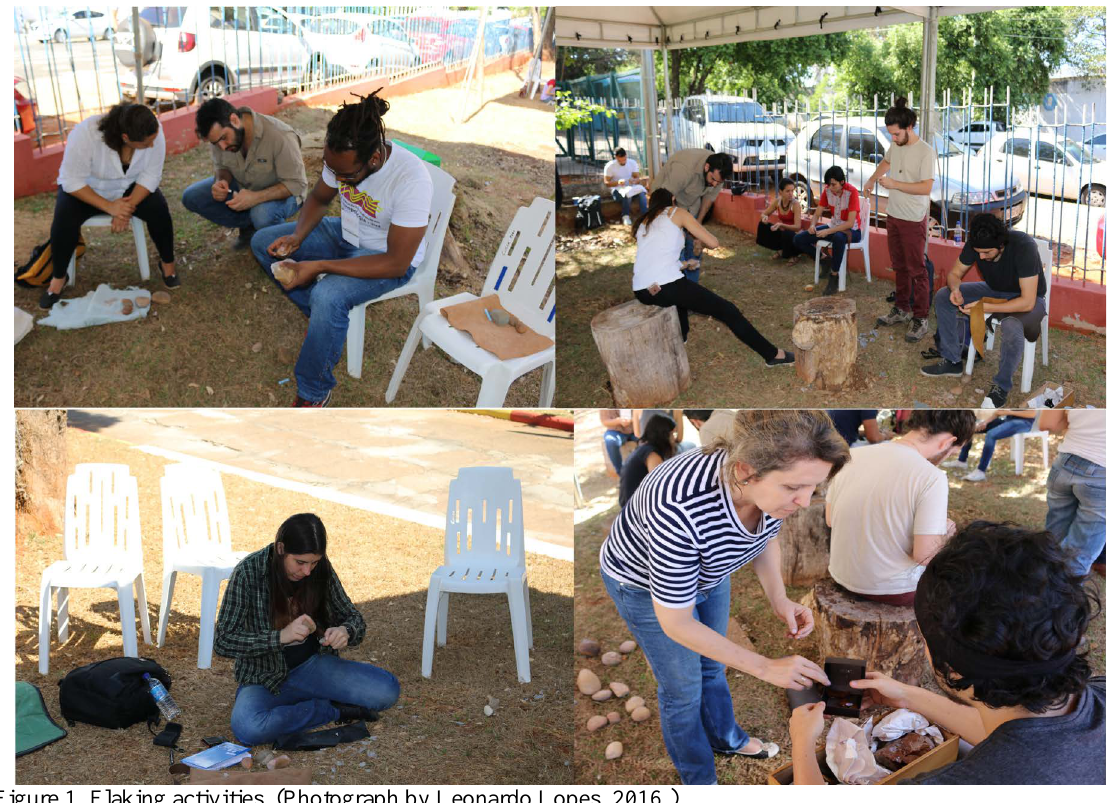
Figure 1. Flaking activities. (Photograph by Leonardo Lopes, 2016.)